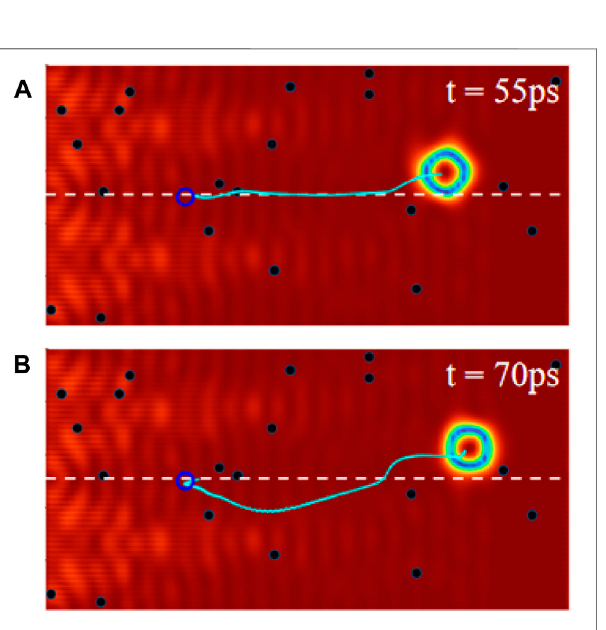
FIGURE 6 | The AFM skyrmion motion trajectories (green curves) with defect concentration 0.1% for (A) A / J (cid:1) 0.05 and (B) A / J (cid:1) 0.15, where the initial positions of skyrmion are represented by the empty blue